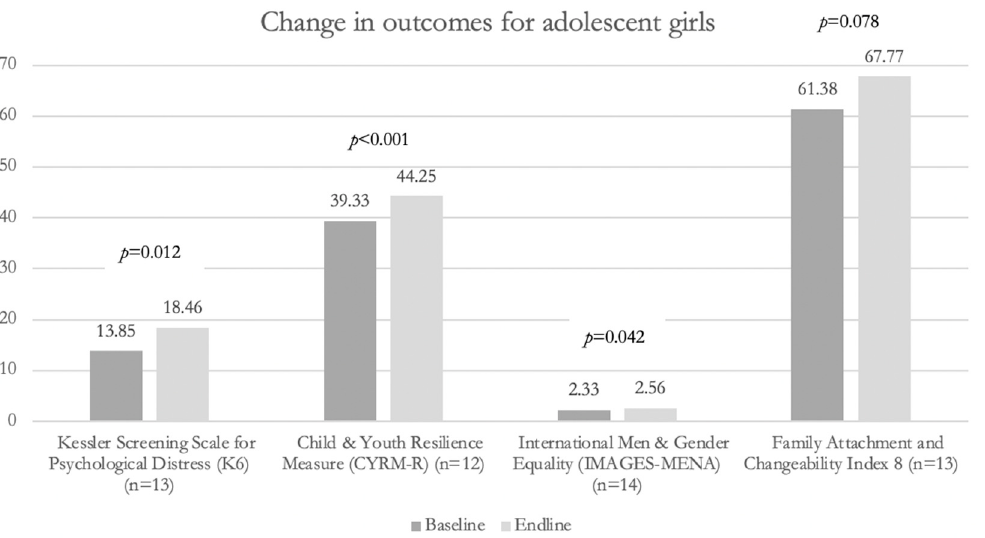
Figure 1. Change in outcomes for adolescent girls only. Note: Baseline and endline data were